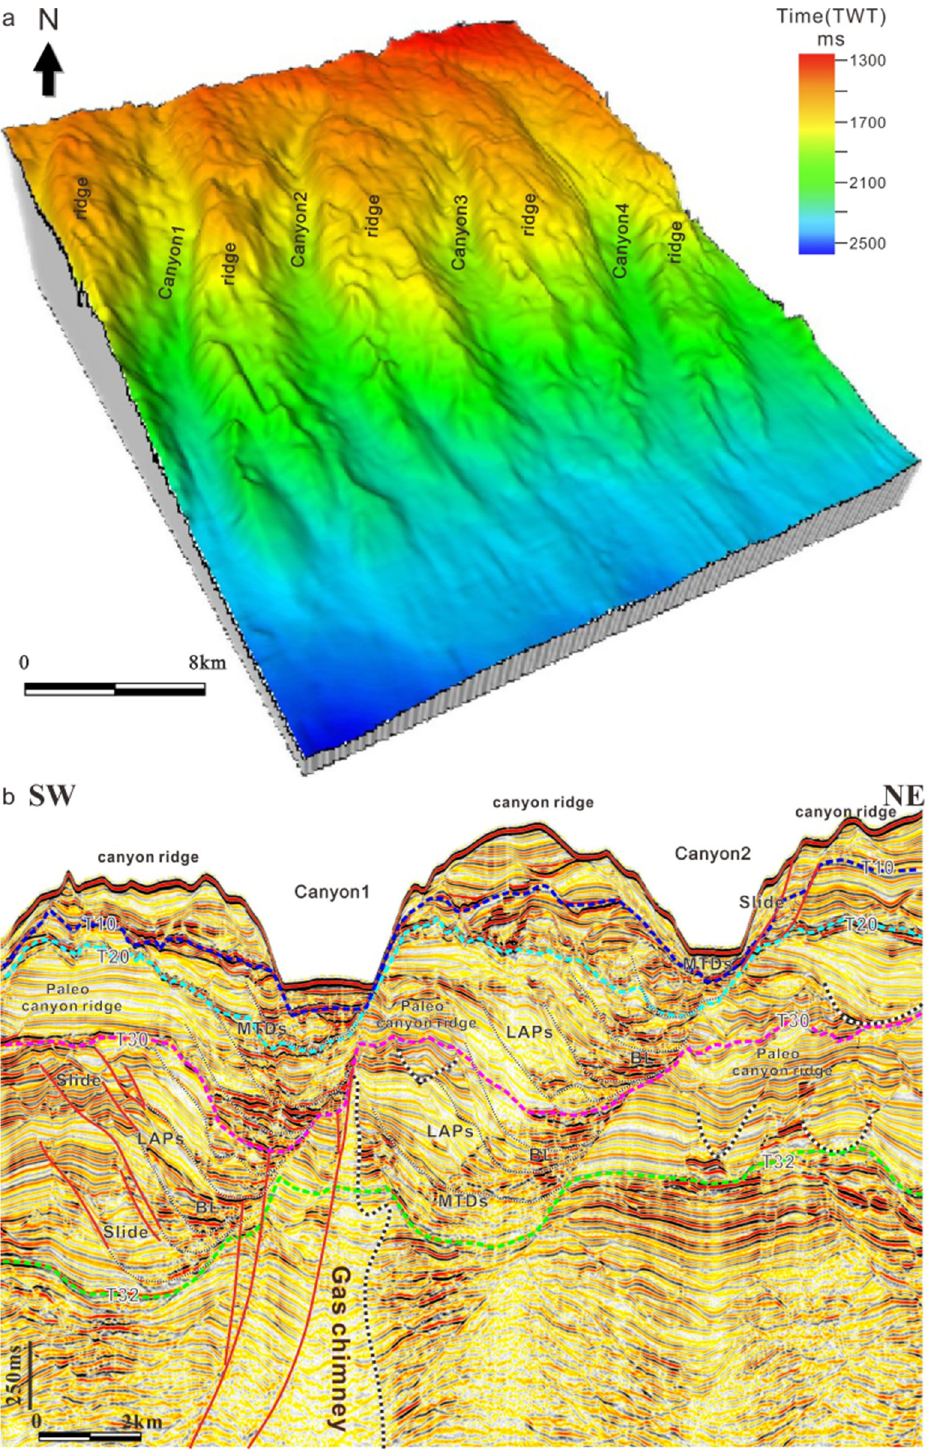
Figure 3. ( a ) 3D view of time depth of sequence boundary of T20(boundary between Pliocene and Pleistoncene); ( b ) typical features of submarine canyons on seismic profile perpendicular to